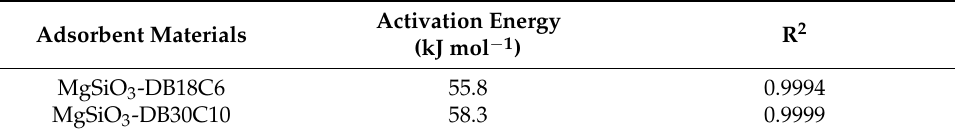
Table 5. Activation energy and correlation coefficient for the Pd(II) adsorption